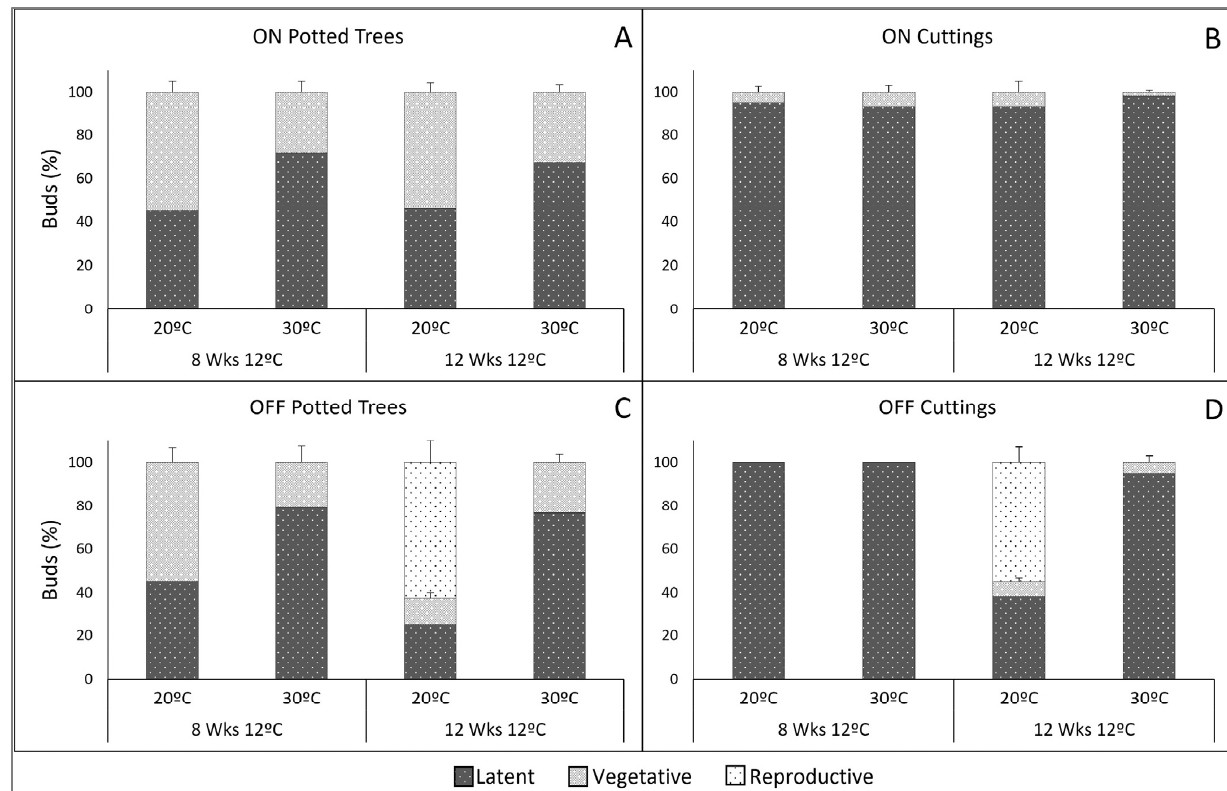
Figure 5. Final bud status (latent, vegetative budburst, or reproductive budburst) after 21 days forcing using (A) bearing (ON) potted trees; (B) bearing (ON) cuttings; (C) nonbearing (OFF) potted trees; and (D) nonbearing (OFF) cuttings. All trees received 8 or 12 weeks of cold accumulation in growth chambers at 12 °C. After the cold treatments, forcing at either 20 °C or 30 °C was applied to both cuttings from the trees and to the same whole trees. Each column represents the mean of 240 buds from four trees (60 buds per tree), in the case of both whole trees and cuttings. Vertical bar = standard errors for vegetative and reproductive bud burst percentages.